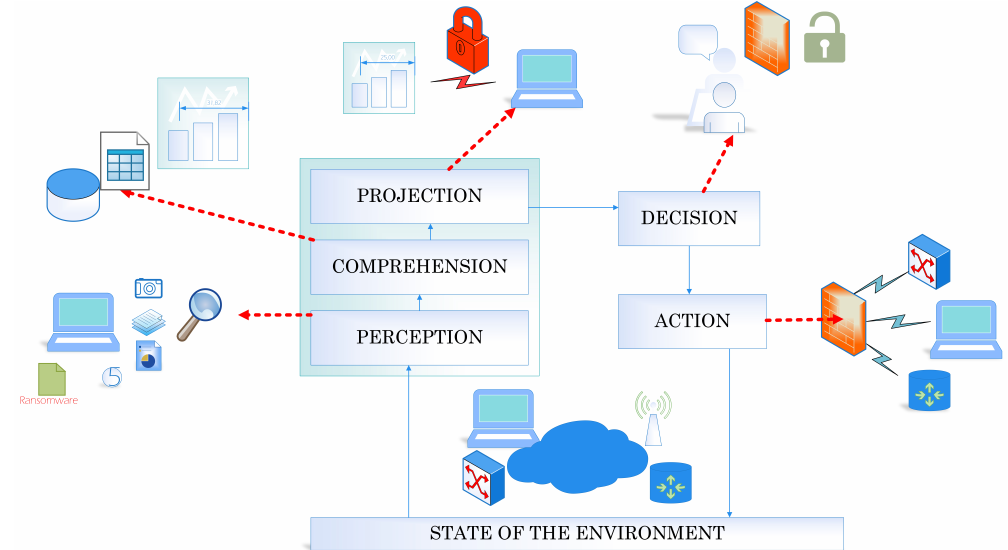
Figure 2. Endsley Situational Awareness Model and Ransomware Protection &